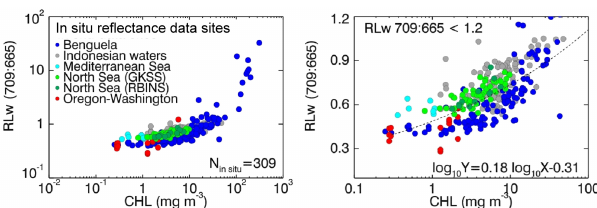
Figure 24. From the CCRR in situ reflectance data set: CHL (mgm − 3 ) vs. RLw band ratio 709:665 with a close-up on the lower range of RLw 709:665 < 1.2 presented in the left figure.